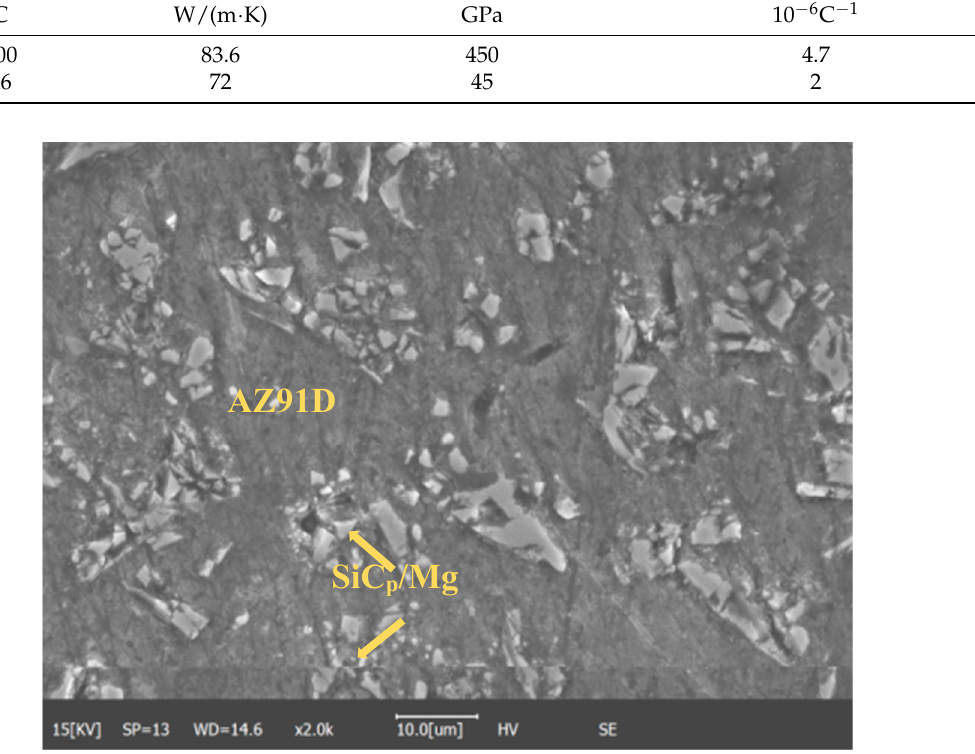
Figure 1. SEM of SiC p /Mg composite.